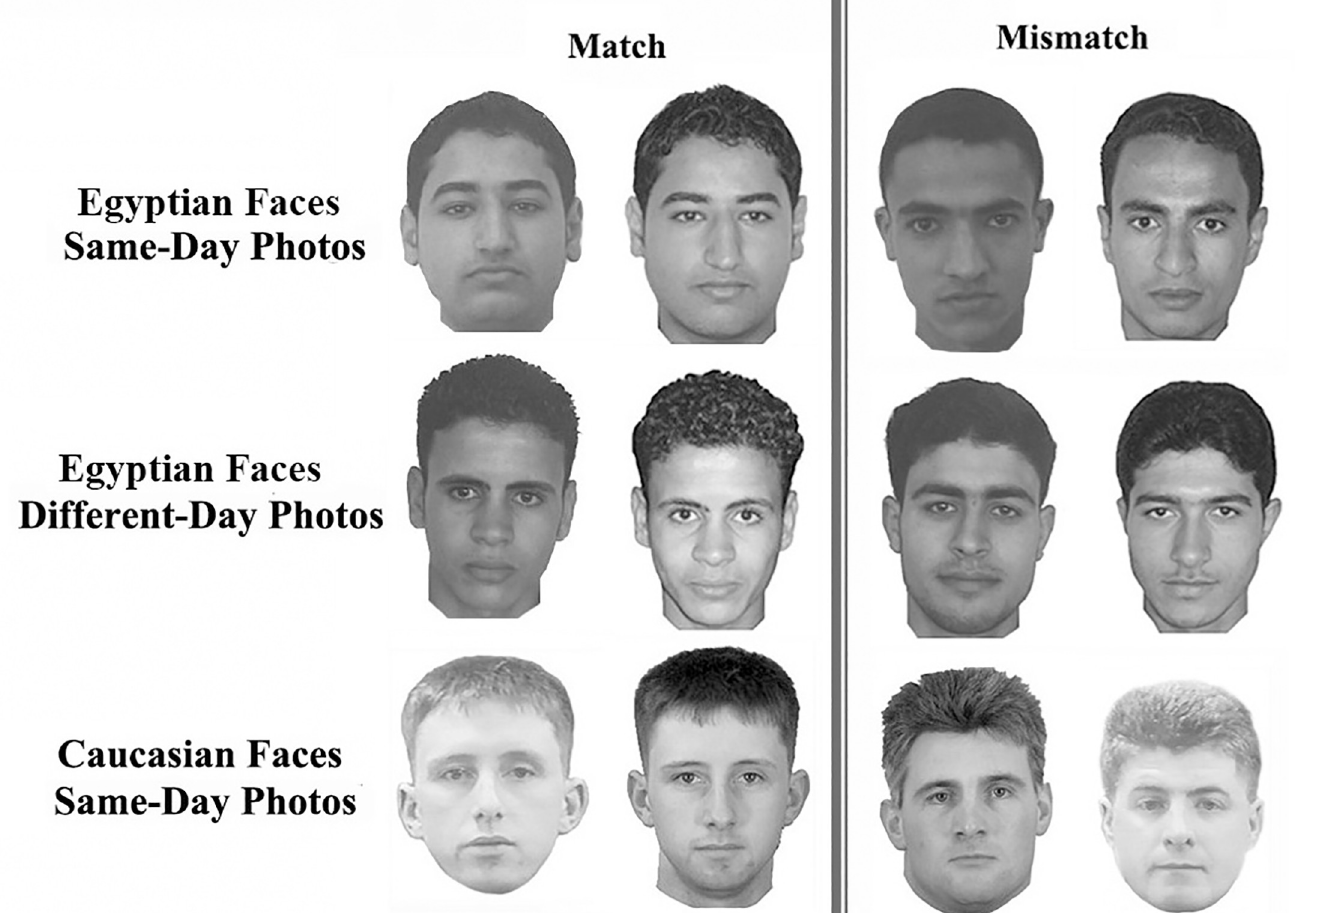
Fig 3. Examples of face-matching tasks used in Experiment 2 and 3. Regarding copyright issues, we could not present examples for the UK face images that were taken in different times.